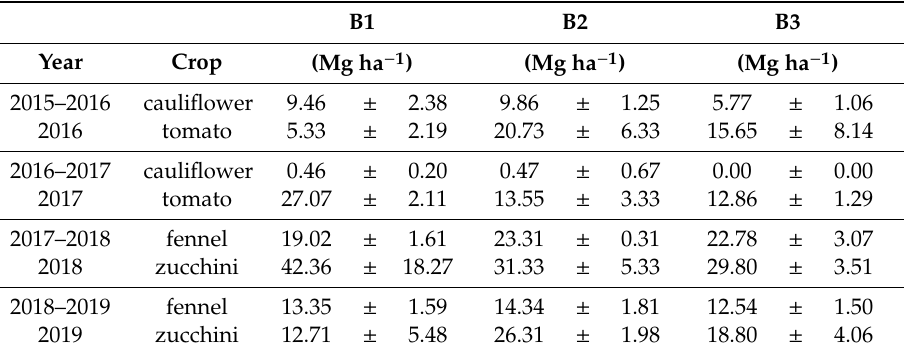
Table 3. E ff ects of the three di ff erent management strategies on cauliflower, tomato, fennel and zucchini marketable yield (Mg ha − 1 ) (B1 = alfalfa as living mulch during both winter and summer periods, flattened with a no-till roller crimper; B2 = clover as living mulch during the winter period, chopped and plowed as green manure; B3 = control without